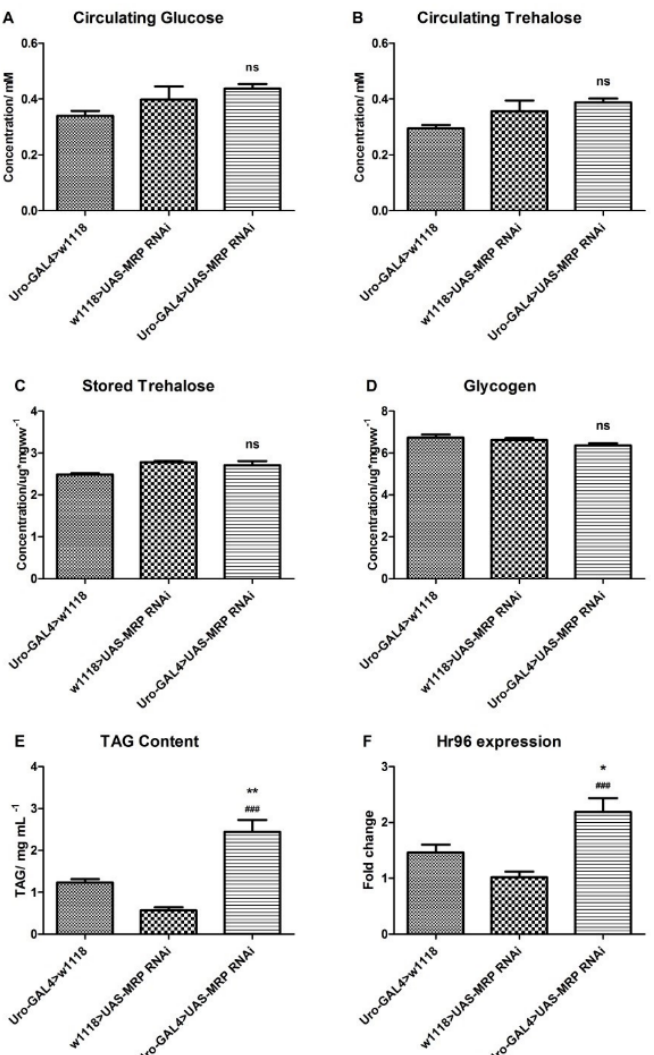
4.3. Loss of MRP in Malpighian Tubules Influences Triacylglyceride Levels The starvation resistance defect, found in Uro-GAL4 > UAS-MRP RNAi flies, estab- lished a possibility for metabolic disruption. Therefore, we measured the carbohydrate and triacylglyceride (TAG) levels of adult flies. The levels of circulating glucose (Figure 2A), circulating trehalose (Figure 2B), stored trehalose (Figure 2C), or glycogen (Figure 2D), MRP was knocked down in the Malpighian tubules. Compared to controls, Hr96 expres- were not significantly affected by the reduction in MRP expression in Malpighian tubules. sion increased significantly when MRP was knocked down in the Malpighian tubules (ap- However, the TAG content of the experimental group (2.44 ± 0.29 mg/mL, p < 0.05, proximately 1.1-fold increase compared to w 1118 > UAS-MRP RNAi group ( p < 0.001) and Figure 2E) was significantly elevated compared to control groups (1.23 ± 0.08 mg/mL for Uro-GAL4 > w 1118 and 0.57 ± 0.08 mg/mL for w 1118 > UAS-MRP RNAi).